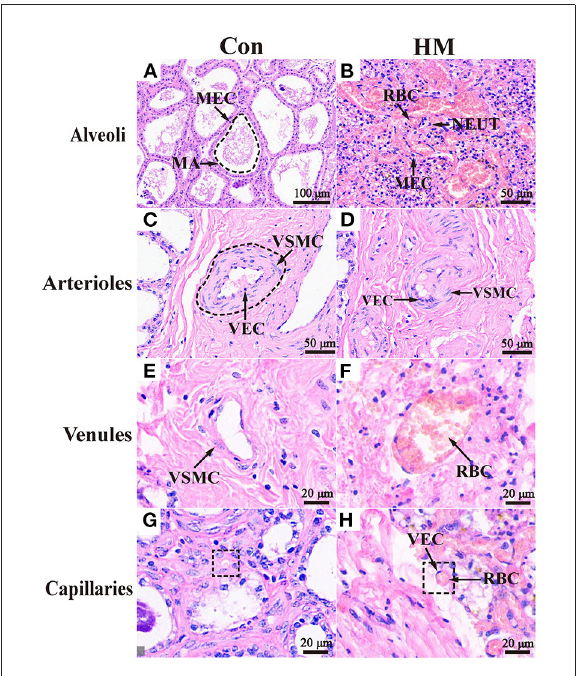
FIGURE1 Pathological observation of the mammary glands in the Holstein cows. (A,B) Pathological variations of the alveoli in the mammary glands of the C and HM groups (100 × ). (C–H) Pathological variations of the arterioles (C,D) , venules (E,F) , and caillaries (G,H) in the mammary glands of the C and HM, respectively (100 × ). MEC, mammary epithelial cells; MA, mammary gland alveolar; RBC, red blood cell; NEUT, neutrophil; LY, lymphocytes; VEC, vascular endothelial cell; VSMC, vascular smooth muscle cell; Con, control group; HM, hemorrhagic mastitis group. Scale bar of 50, 100, and 20 µ m represents 400 × , 200 x, and 800 × magnification,